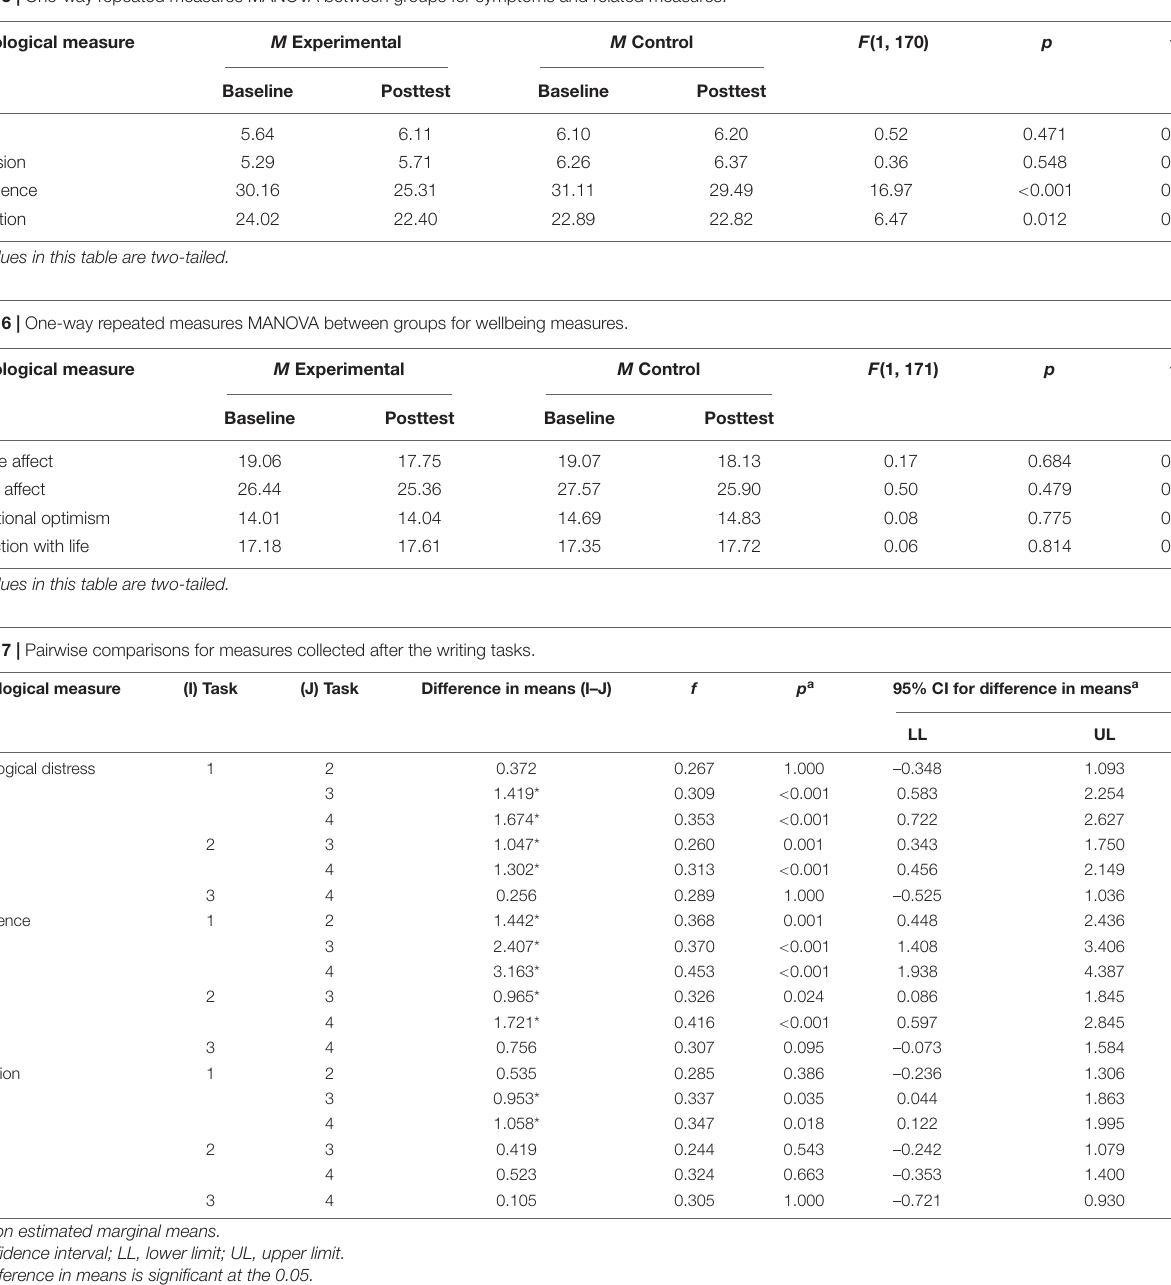
TABLE 5 | One-way repeated measures MANOVA between groups for symptoms and related measures. Psychological measure M Experimental